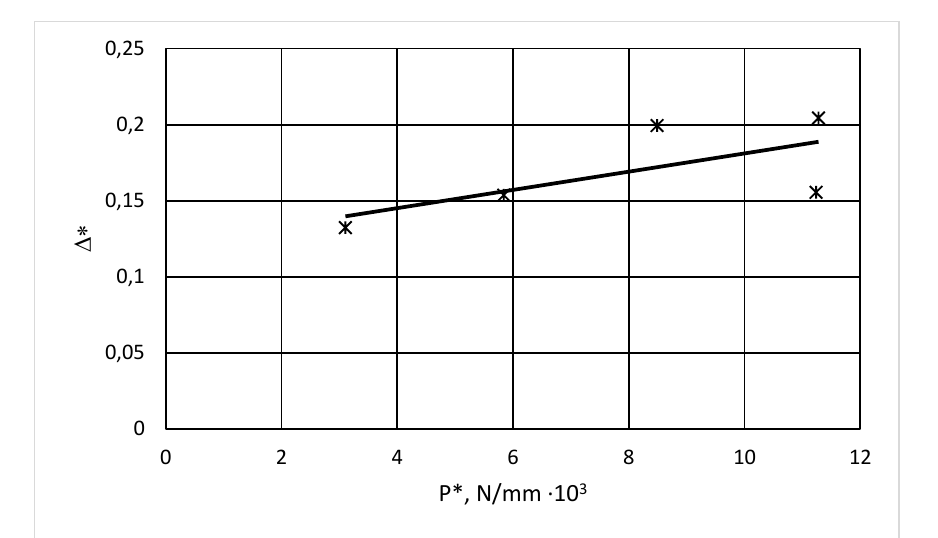
Fig. 7. Dependence of the relative thickness  * of the workpiece at a radius of 32 mm on the value